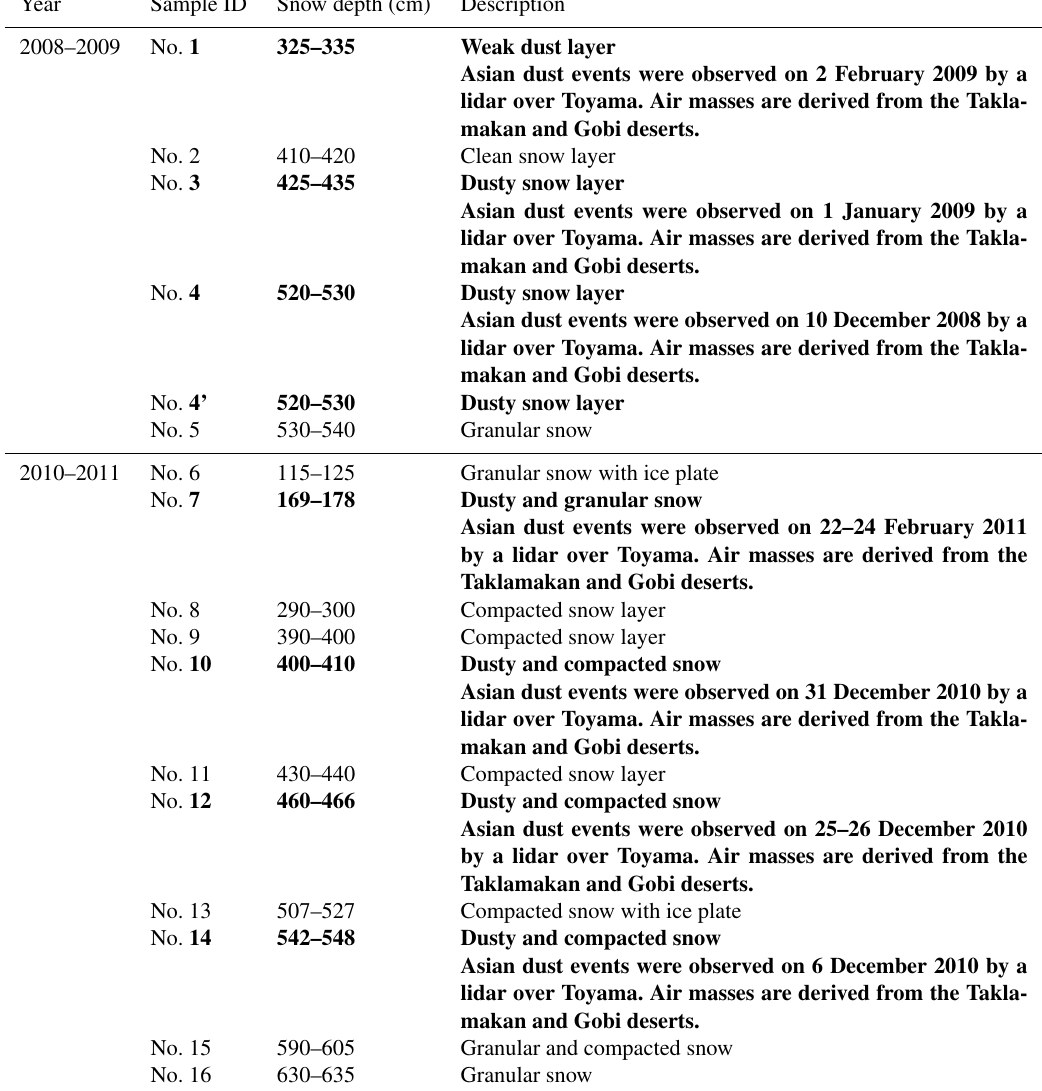
Table 1. Descriptions of snowpack samples collected from a pit at Murodo-Daira near Mt. Tateyama, Japan, in 2009 and 2011. Snowpack sample no. 4 (cid:48) was collected from different snow pit sequences parallel to sample no. 4 (cid:48) . Bold letters represent dust